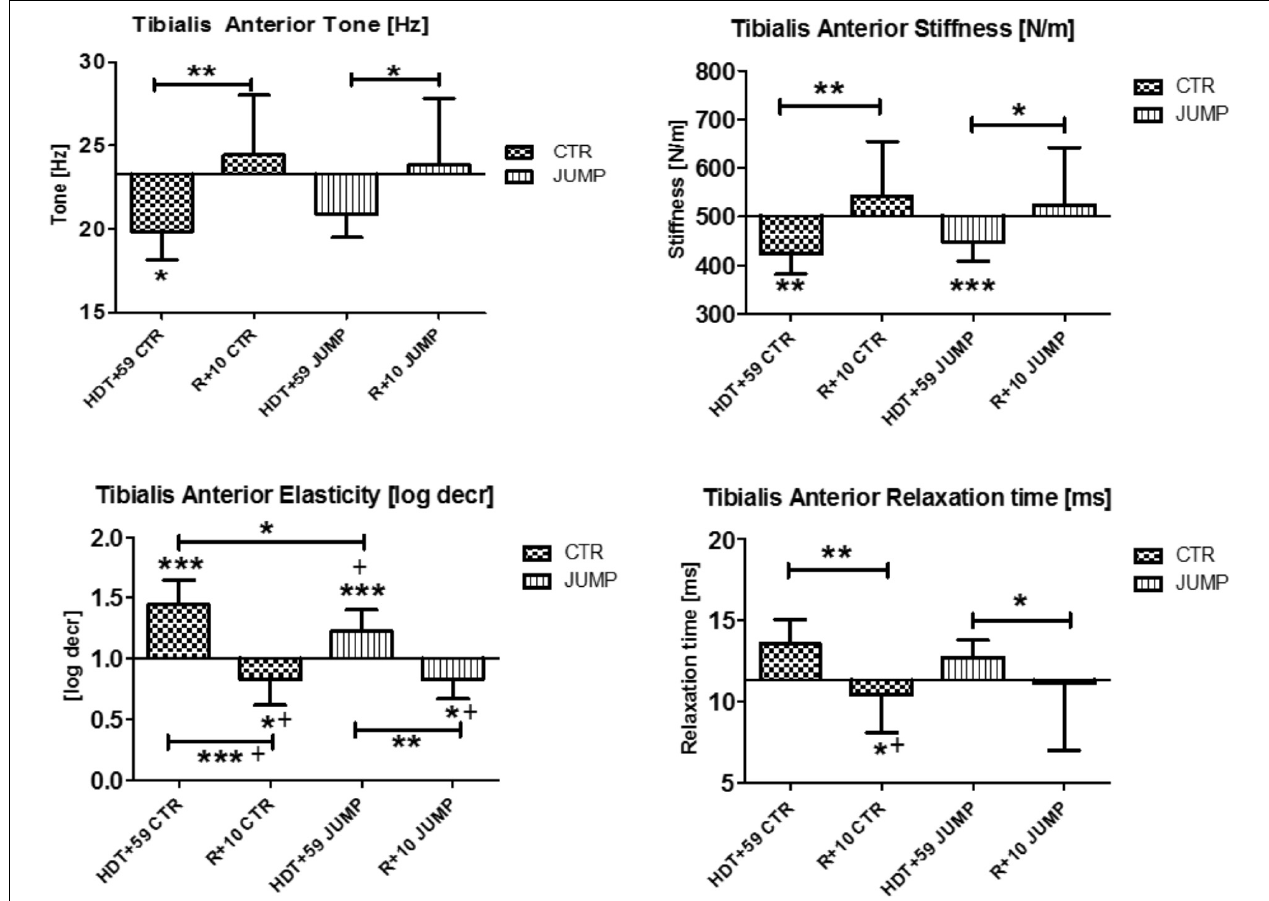
FIGURE 5 | Tibialis anterior (MP9/10). Oscillation signal patterns in RSL bed rest study. P -values (asterisks) refer to each graph. Error bars = SD (standard deviation). ABD = average baseline data (Tone HDT+1 = 23.29; Stiffness HDT+1 = 502.43; Elasticity HDT+1 = 1.0; Relaxation HDT+1 = 11.33). ∗ p < 0.05, ∗∗ p < 0.01, ∗∗∗ p < 0.001 ± SD, +Spearman ρ